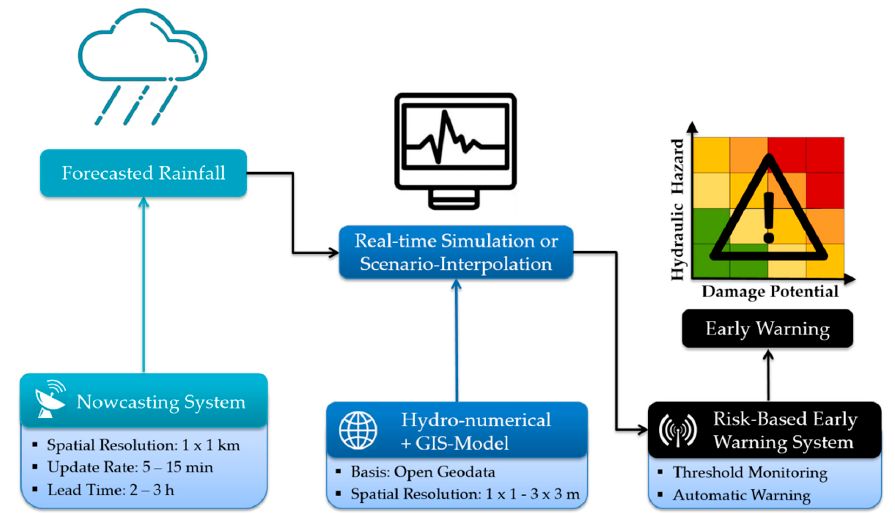
Figure 1. Design and process flow of the Risk-based EWS for pluvial flash floods [35] .